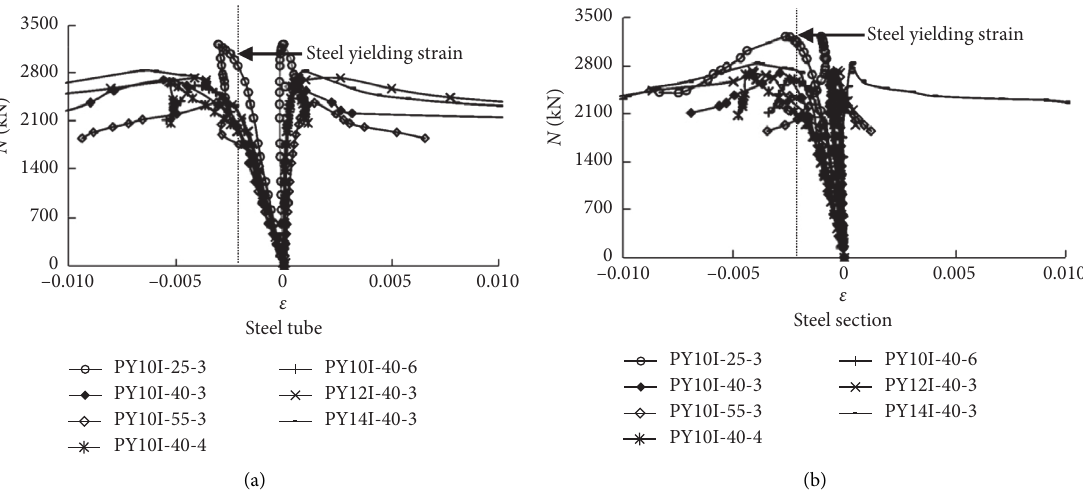
Figure 4: Curves of load-longitudinal strain on (a) steel tube and (b) steel